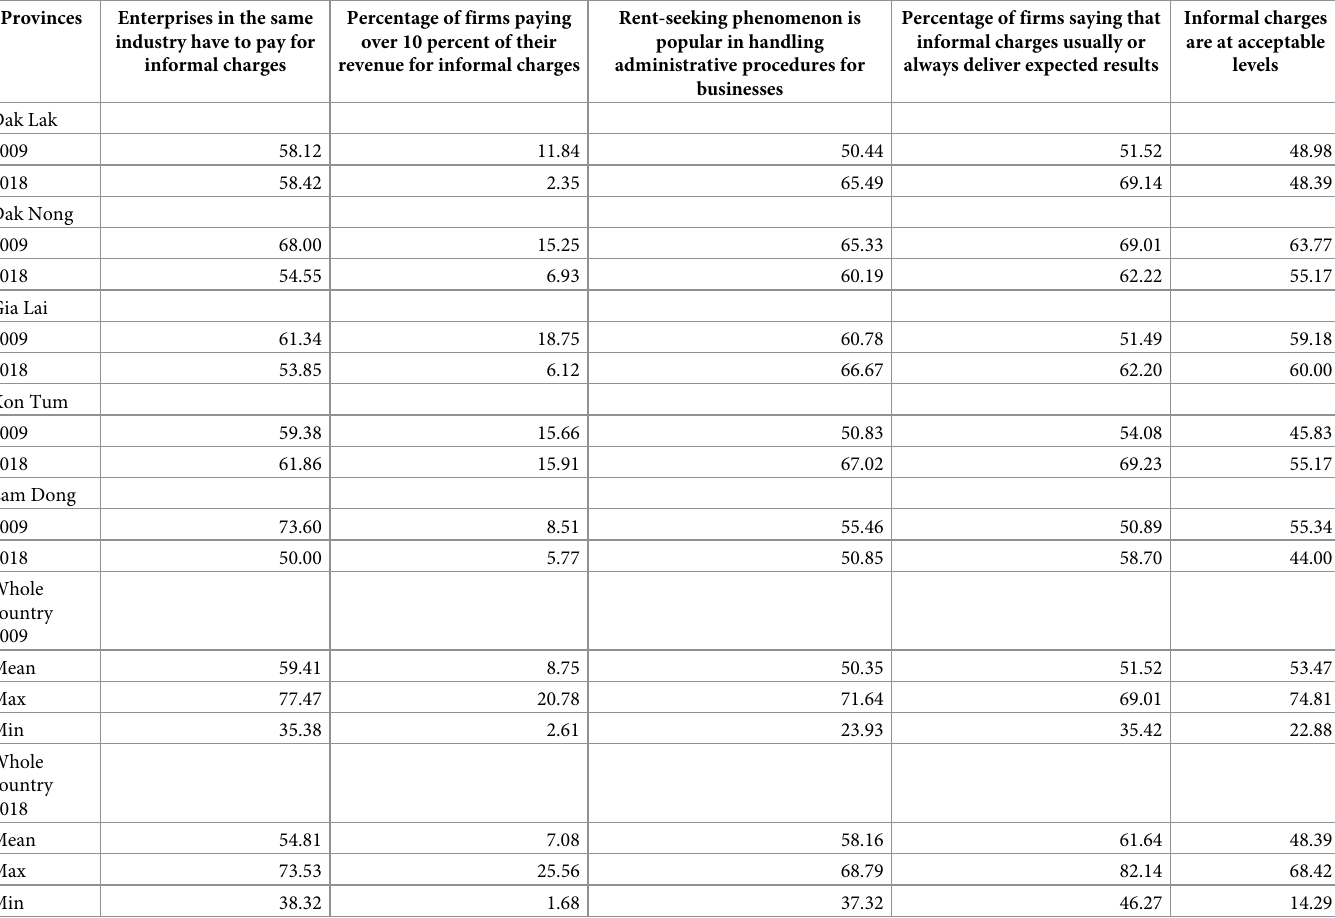
Table 2. Assessment of informal costs by enterprises in the Central Highlands. Unit : Percent of agreed enterprises . Provinces Enterprises in the same industry have to pay for